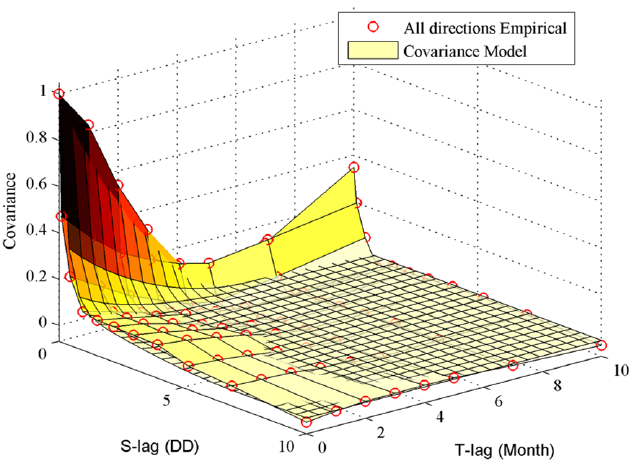
Figure 4. Observed (red circles) and fitted covariance of the residual GOCs (all direction empirical refers to the isotropy assumption, which means the same meaning in all directions).